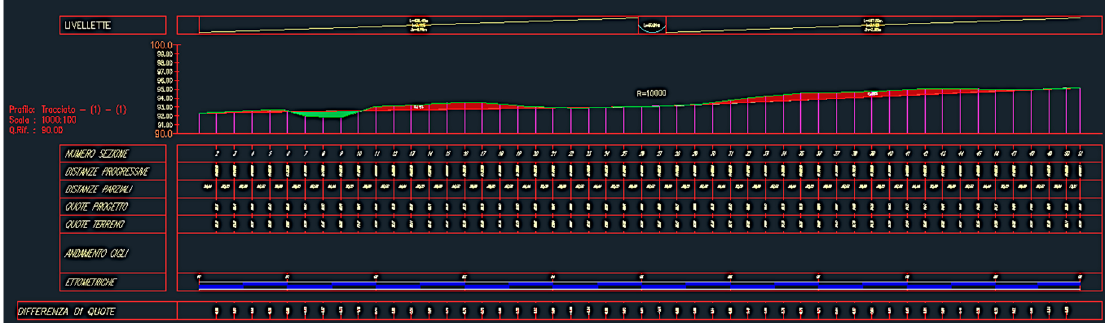
Figure 8. Top view of the road modelon the Digital Terrain ModelDTM. Figure 9. Terrain and road vertical Figure 9. Terrain and road vertical profiles.